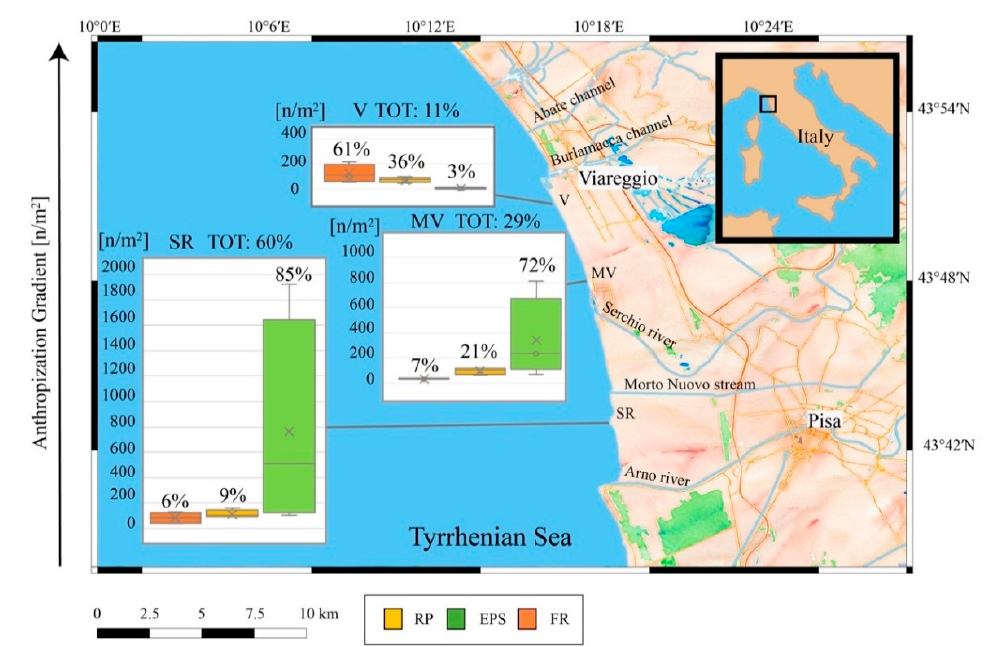
Figure 1. Geographical location of the three sampling sites, and distribution of the density of MPs sampled in the three sites (SR, MV and V). The anthropization gradients grow from the SR to the V site, and in geographical terms from south to the north. The x in the boxplot represent the mean values, the continuous lines the median values, the limits of the “boxes” the 75th and 25th percentile and the whiskers the maximum and minimum limit. In the SR site for the EPS fraction there is a high variability of the distribution (InterQuartile Range = 1254.68) as well as in the MV site (InterQuartile Range = 194.68). Image made using Stamen Watercolor/OSM base map in Qgis 2.18.2.